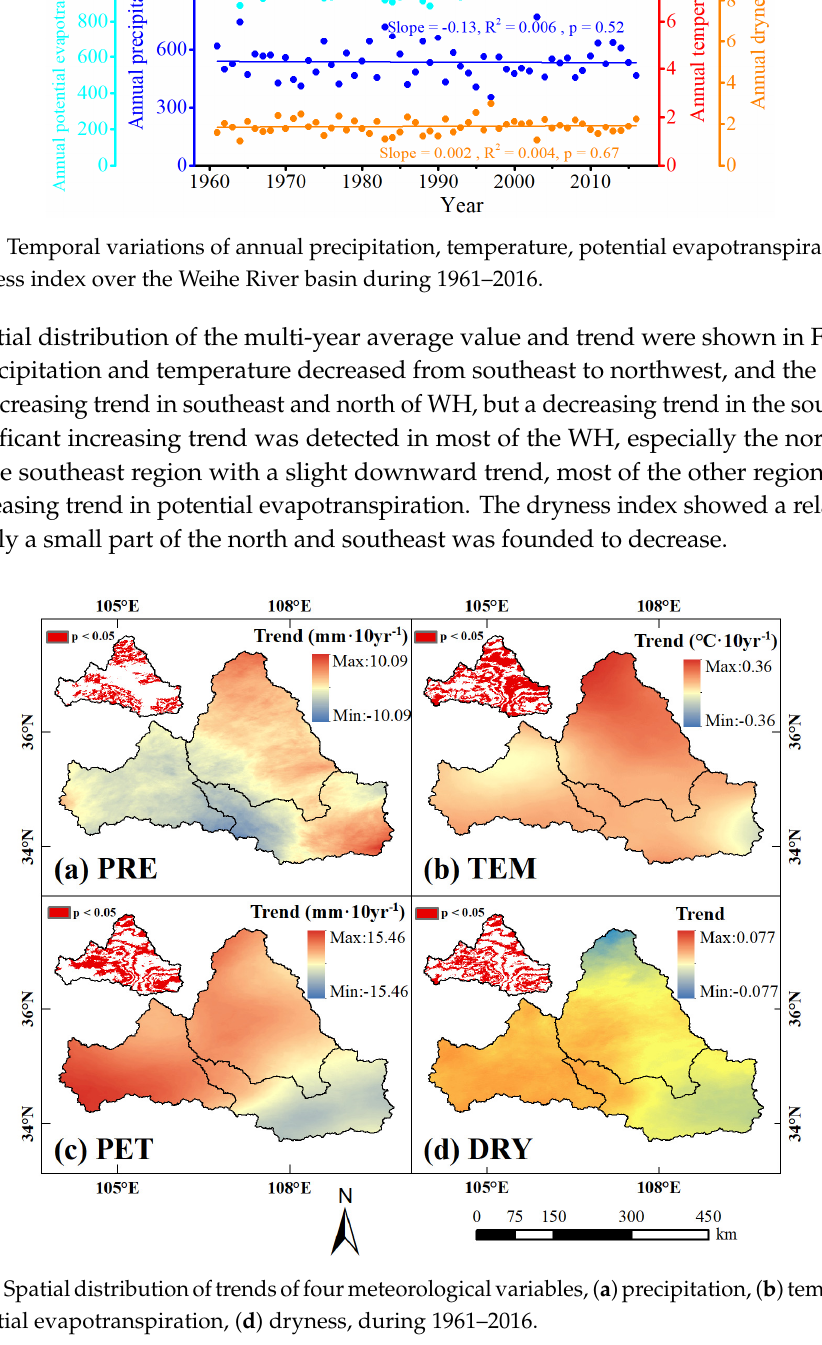
8 of 22 Figure 2. Monthly simulated streamflow against observed streamflow of Huaxian station for the calibration period (1962–1969) and validation period (1970–1976). 4.2. Climate Change over the Weihe River Basin Four meteorological variables (i.e., precipitation (PRE), temperature (TEM), potential evapotranspiration (PET), and dryness index (DRY)) were investigated in this study. The regional mean of the meteorological variable was calculated at the inter-annual scale (Figure 3). During the